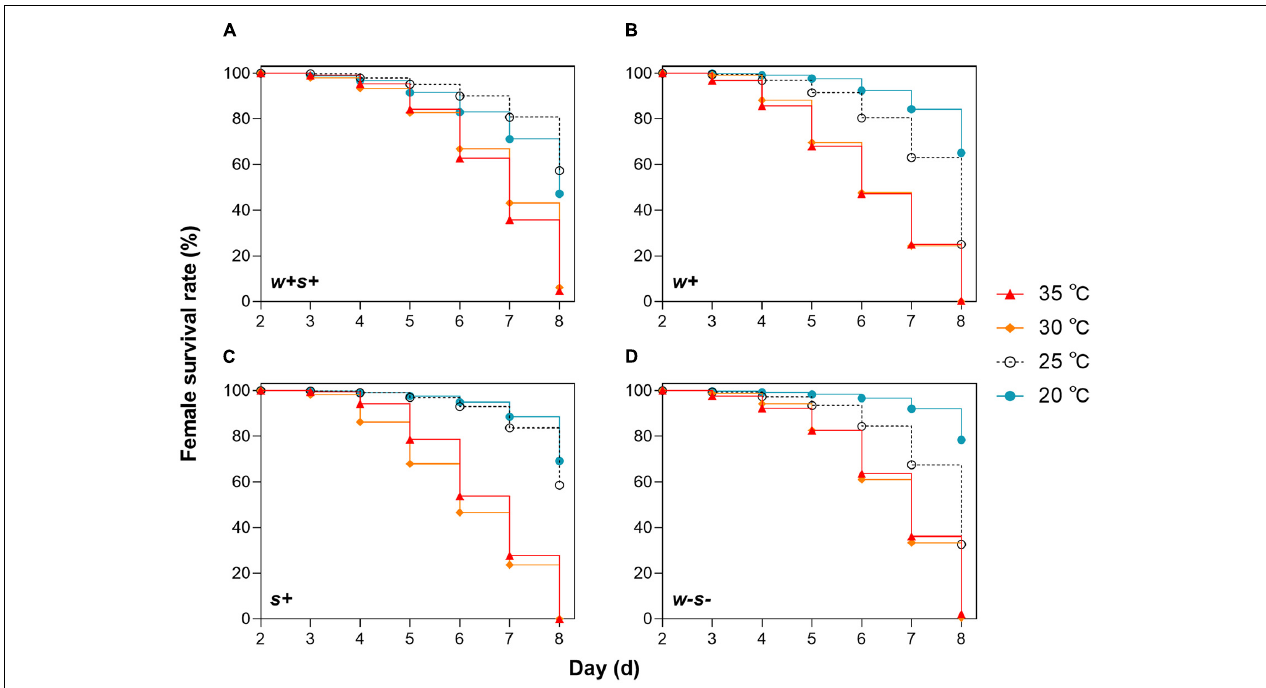
FIGURE 1 | Survival rates of four spider mite strains over 8 days under different temperatures. (A) Wolbachia and Spiroplasma co-infected strains ( w + s +), (B) singly Wolbachia -infected strains ( w +), (C) singly Spiroplasma -infected ( s +), and (D) uninfected stains ( w-s-